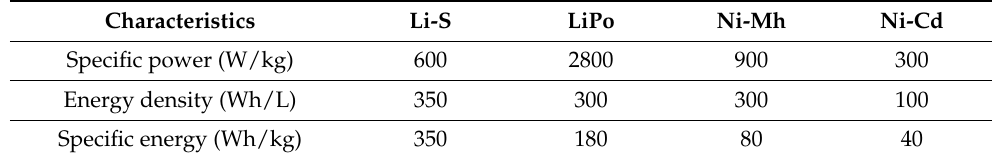
Table 2. Comparison of different batteries